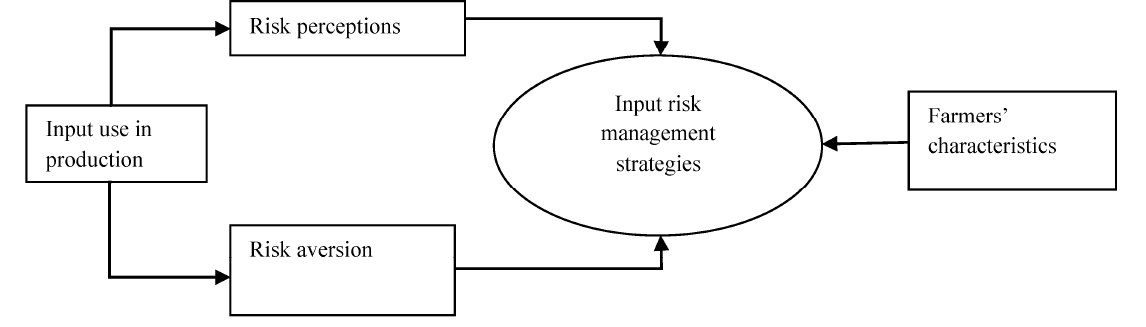
Figure 1. Conceptual framework of the study.